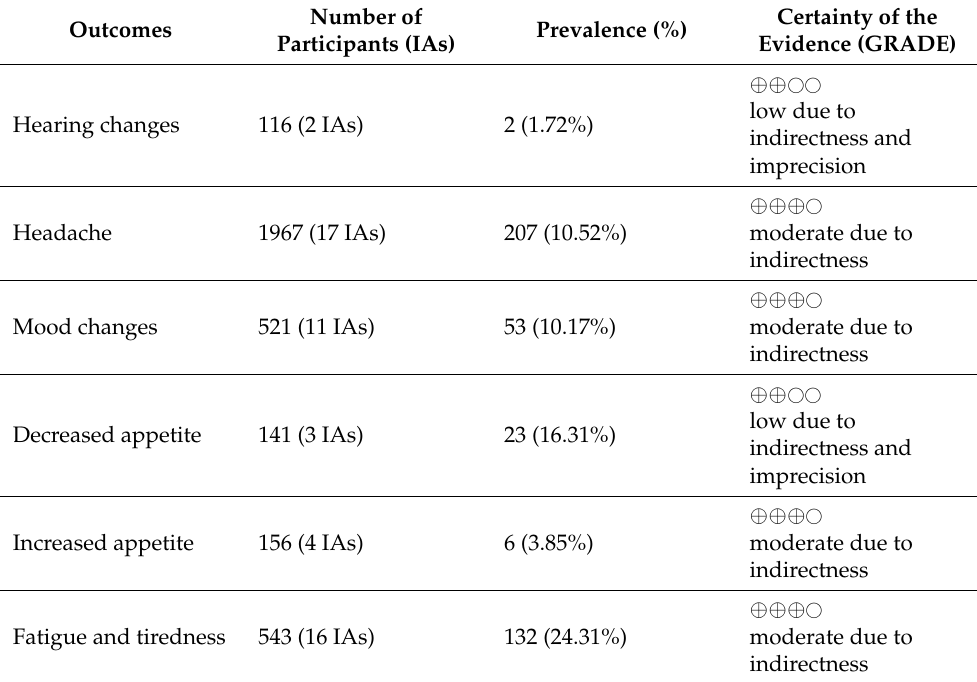
Table 7. Summary of ISO therapy adverse events: mood and neurological